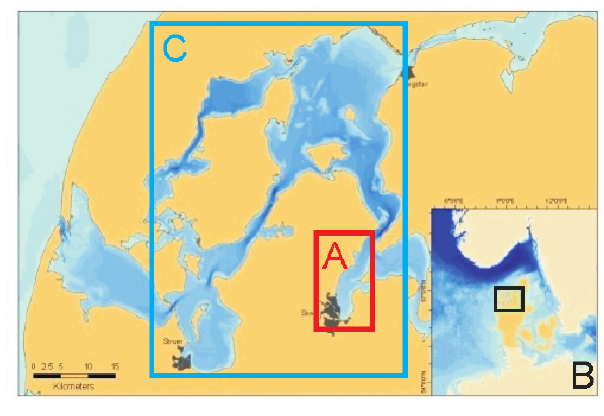
Fig. 1. Map of the Limfjord area. The virtual system (ecological-social-economic or ESE-model) covers the ecology of Skive Fjord (A), mussel fishery activities in the entire fjord (B), and line mussel culture farms in the central area of the fjord (C).